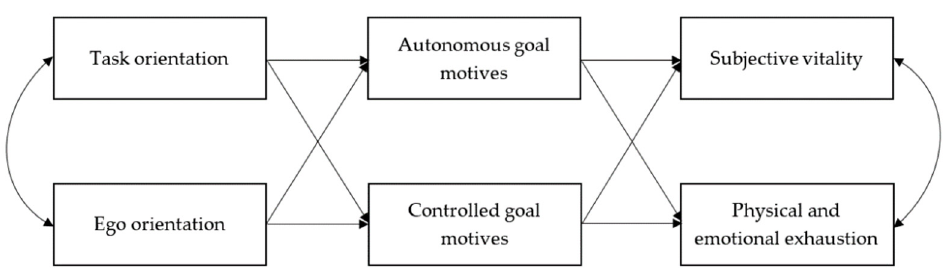
Figure 1. Hypothesized path model of the associations between task and ego orientation, autonomous and controlled goal motives, subjective vitality, and physical and emotional exhaustion.